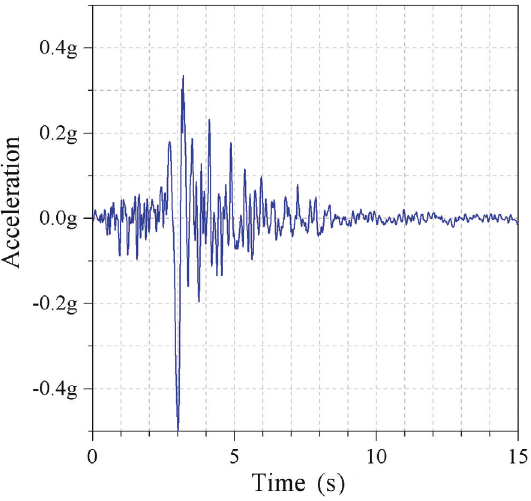
Figure 5: Motion records selected for the analysis.